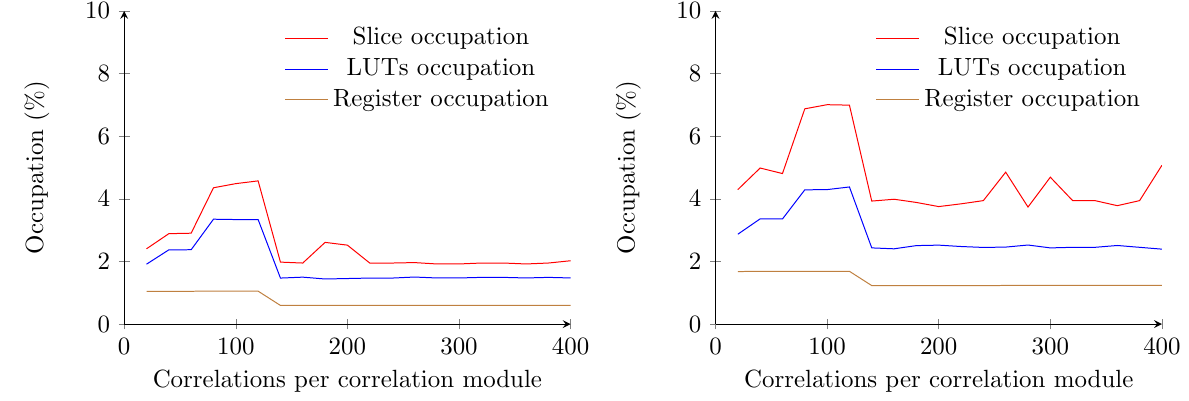
Figure 12. Occupation of the receiver using the optimized correlation implementation with a two bit-wide sample buffer. One transmitter correlation ( left ) and four transmitters correlation ( right ) are shown.